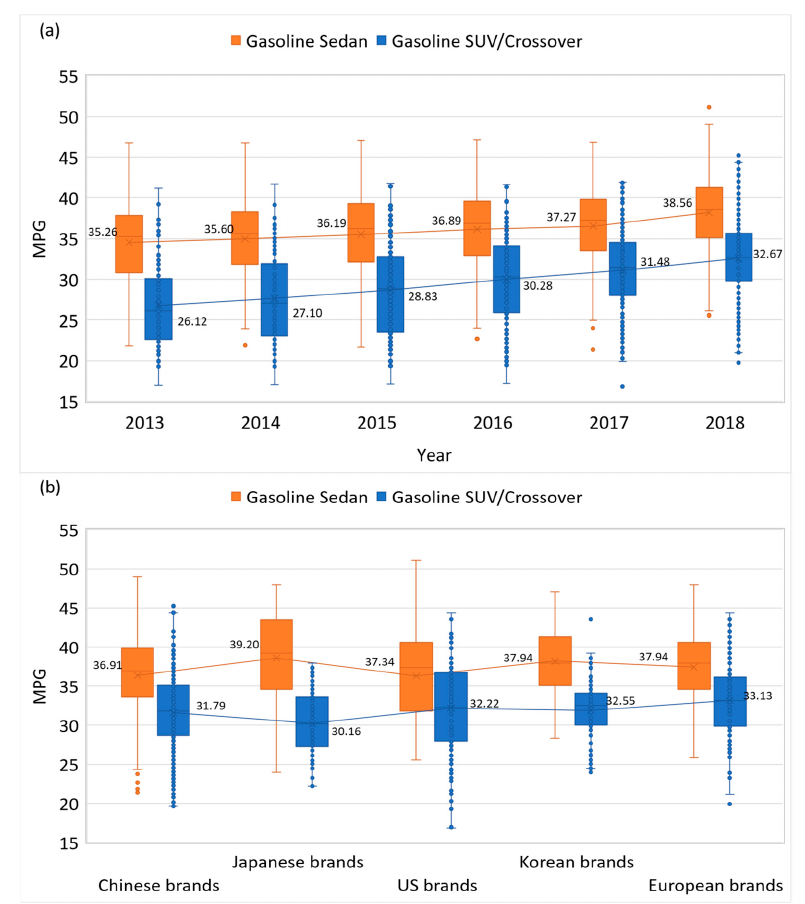
Figure Figure 9. ( a ) Distributions of vehicle model Miles per Gallon (MPG) by year in 2013–2018; ( b ) distributions of vehicle model MPG by vehicle brand in 2013–2018.